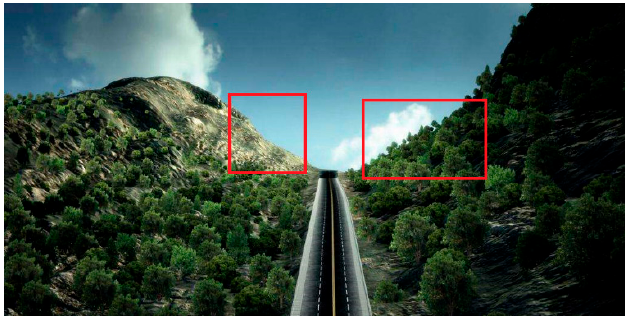
Figure 4. The effects of vegetation on the skyline are illustrated in the areas enclosed by the red